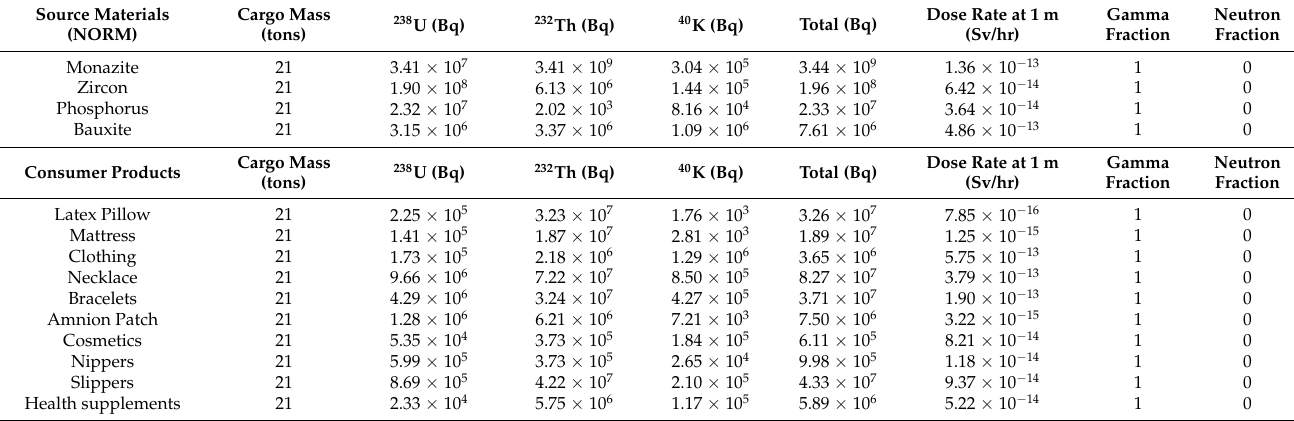
Table 3. Radiological input data used in RADTRAN code for assessment of population/collective dose and risk. Source Materials (NORM)